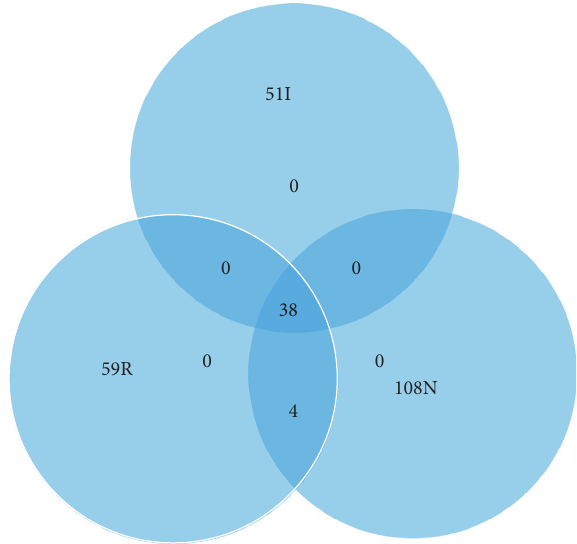
Figure 1: Number of single mutation at Pfdhfr codons N51I, C59R, and S108N.